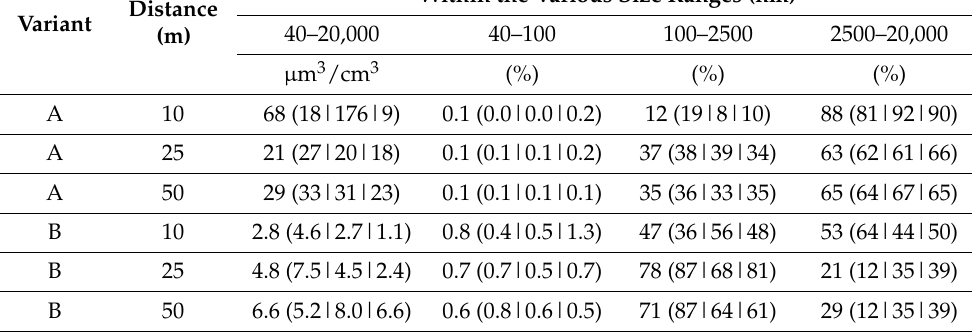
Table 3. The volume of additional aerosols in air volume and percentage terms at 150 cm averaged for the left and right side walls and in the axis of the excavation assuming that the consumption of solution by the aerosol generator is 1 cm 3 /min. The values for the left side wall, center and right side wall of the excavation are given in brackets. Average Volume Concentration of Additional Aerosols in µ m 3 /cm 3 Within the Various Size Ranges Distance Variant (m)